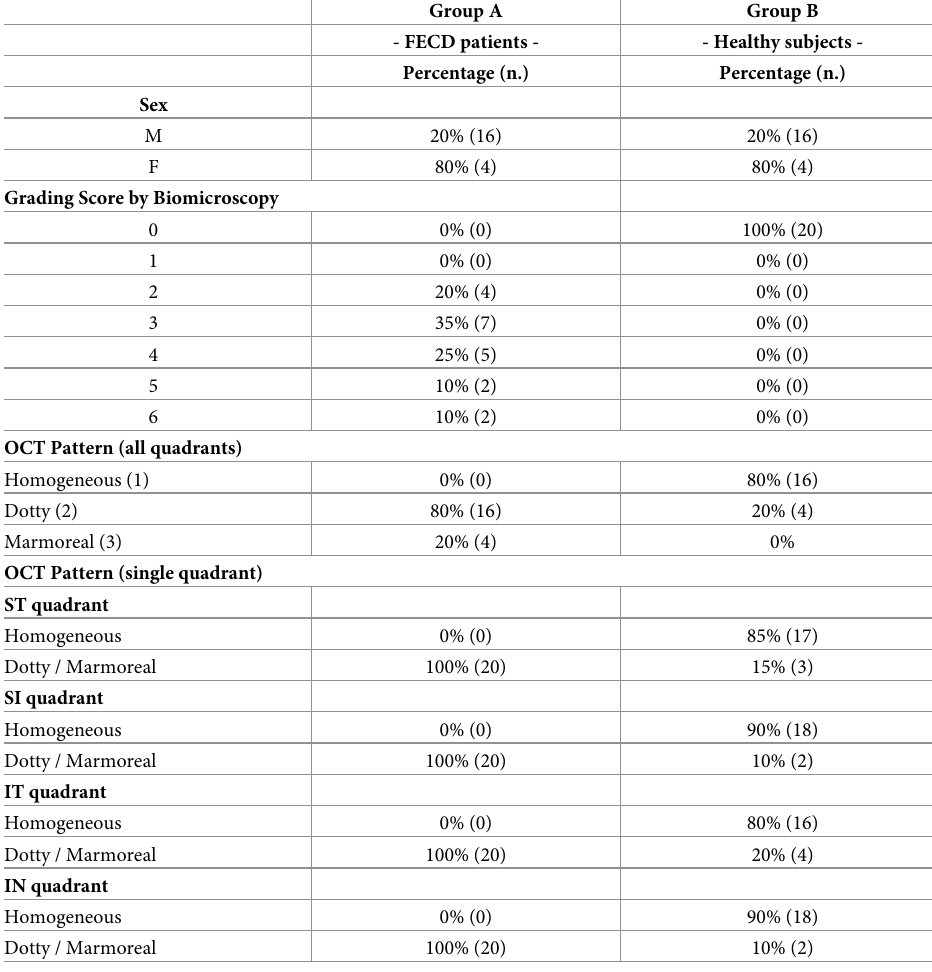
Table 2. Biomicroscopy, OCT pattern and